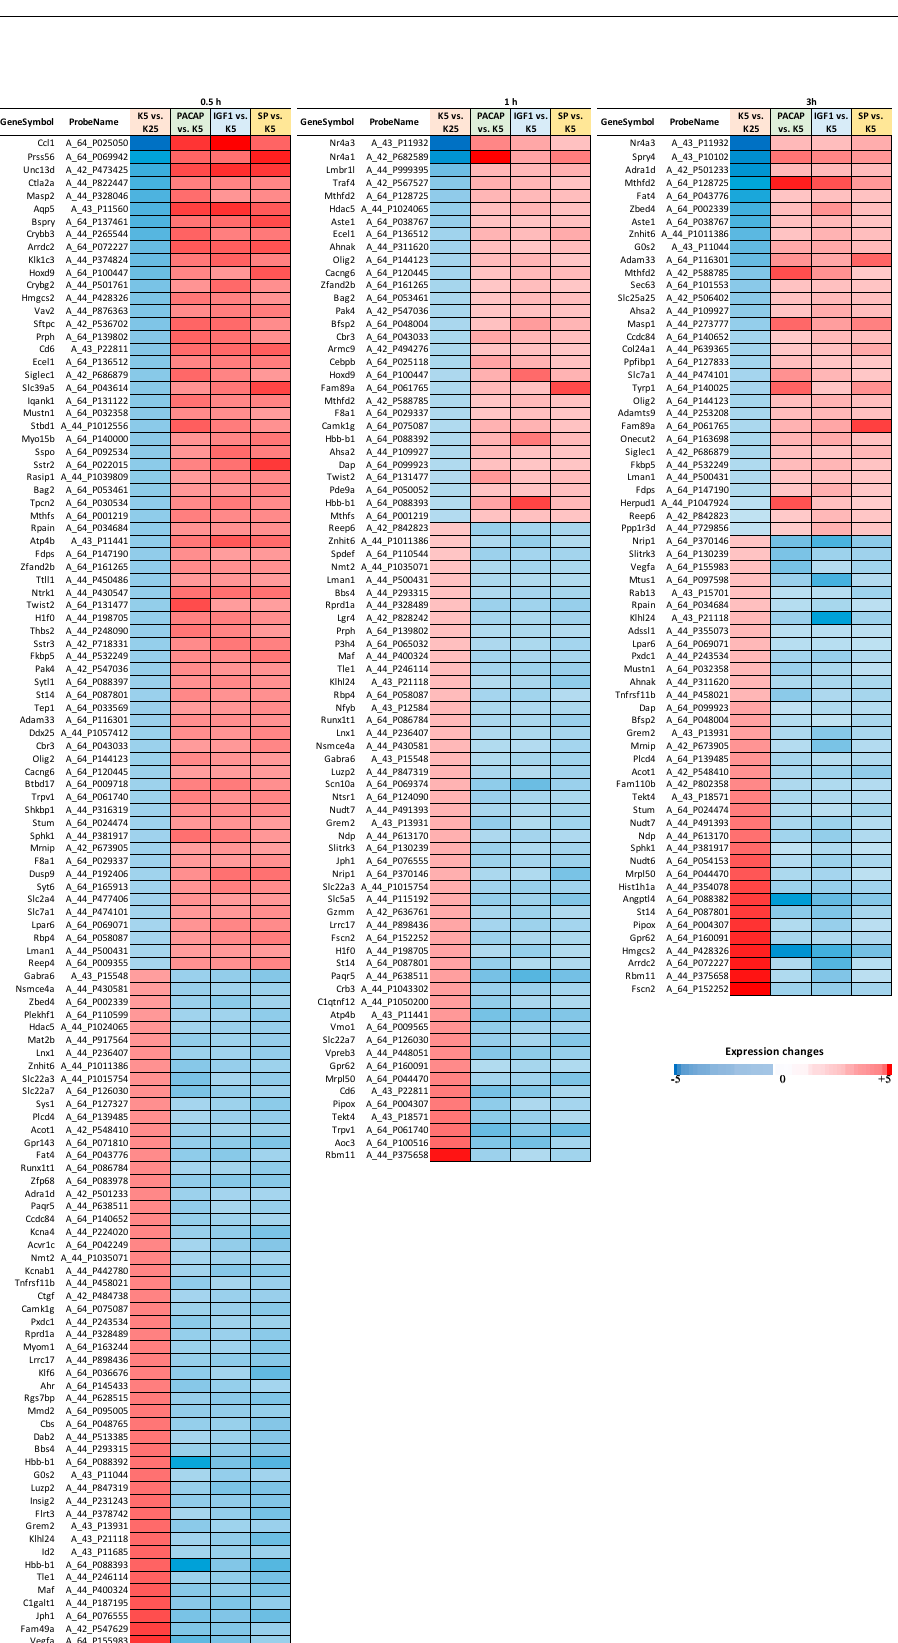
Figure 2. Heat maps showing the 175 core set genes, which were deregulated in CGNs during apoptosis or rescue by GFs and showed opposite expression in at least one-time point. Among them, 117 genes showed an opposite expression pattern at 0.5 h, 78 genes at 1 h and 67 genes at 3 h. Fold changes are shown by colors.